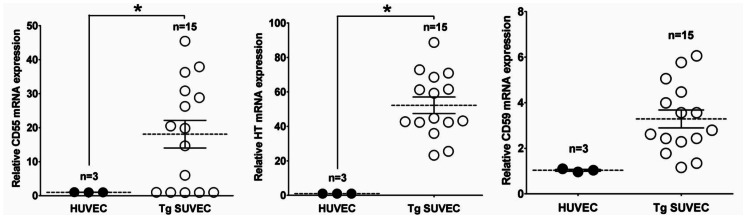
mRNA expression patterns of the transgenes in transgenic SUVECs.Scattered dot plots represent mRNA transcript levels for hCD55 (left), HT (middle), and hCD59 (right) in individual SUVECs. Each value derived from transcripts of the transgene in Tg SUVECs after normalization relative to β-Actin (internal control) genes, were compared with that of a HUVEC defined as 1.